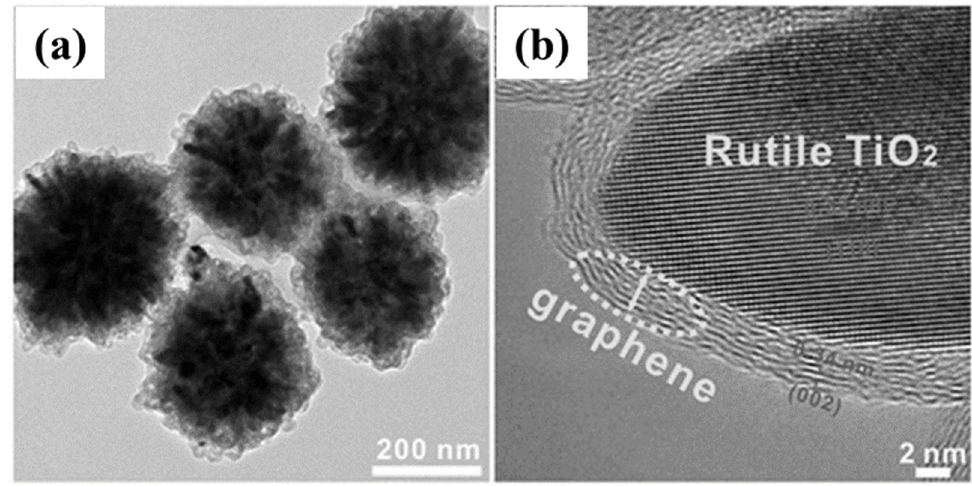
Figure 5. ( a ) TEM and ( b ) HR-TEM of graphene-rich petal-like rutile TiO 2 from 0-D CDs and TiO 2 precursors (adopted with permission from [119], 2016 WILEY-VCH Verlag GmbH and Co. KGaA,